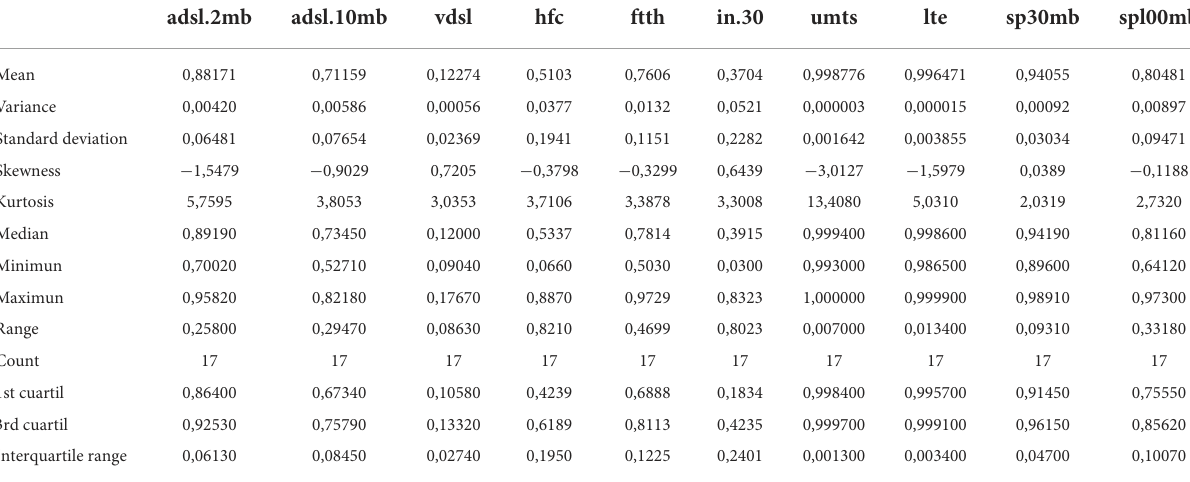
TABLE 1 Descriptive summary of the variables of broadband technology coverage in Spain in 2019.